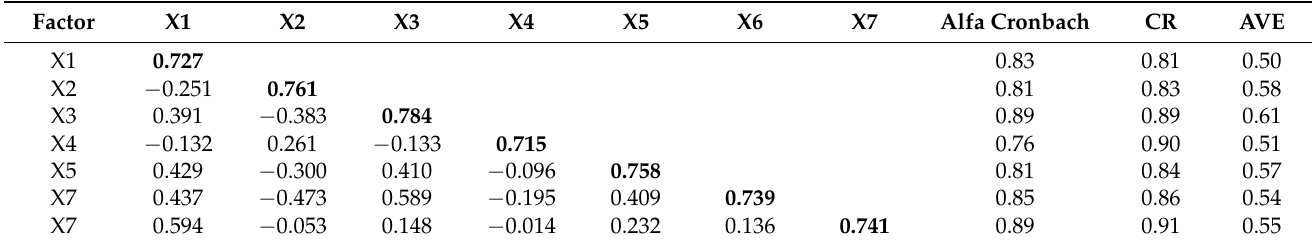
Table 3. Reliability and validity of measurement